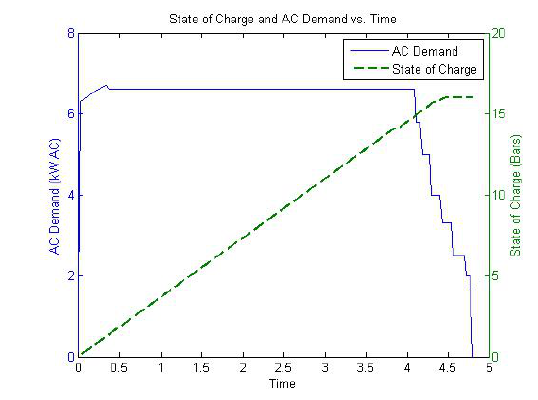
Figure 4: AC Charging Profile for Alta’s lithium-ion battery